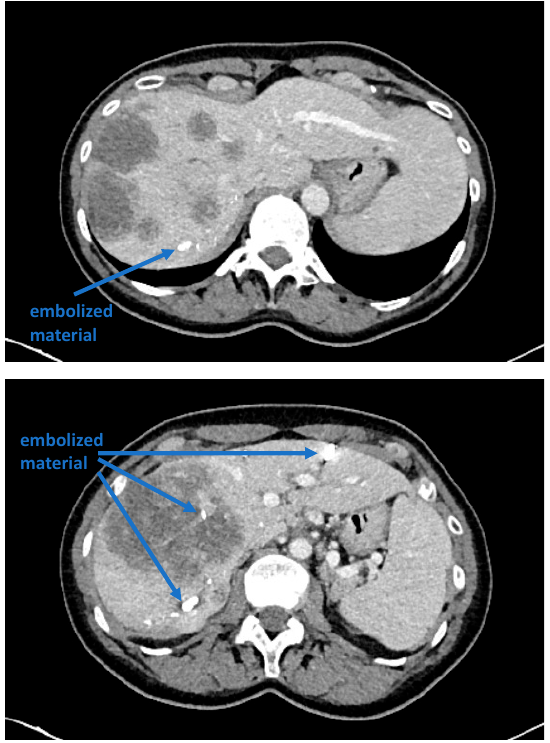
Figure 1. A patient with a multilocular, large hepatocellular carcinoma, a small left lobe that would not suffice to avoid liver insufficiency after resection, and insufficient portal venous embolization.